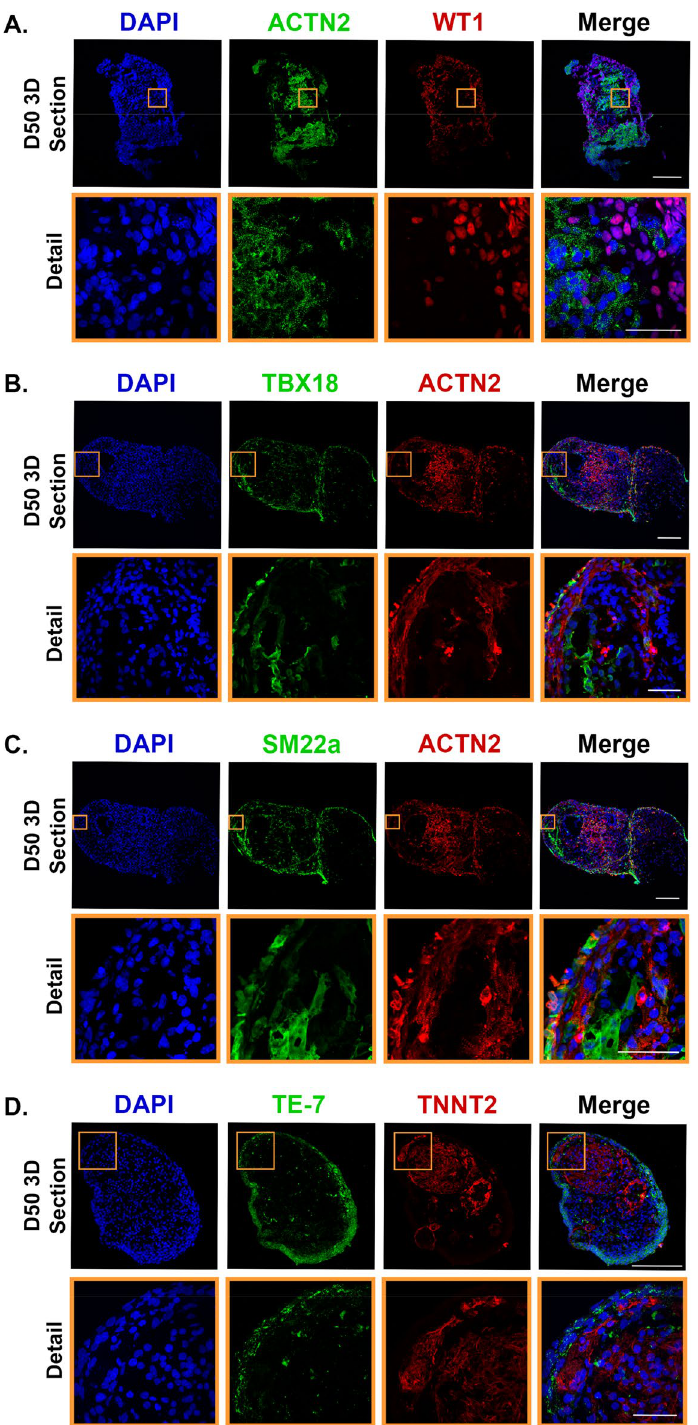
Figure 3. Long-term 3D culture of hOCMTs recapitulates advanced cardiac morphology and cellular heterogeneity in vitro showing markers for cardiomyocyte, epicardial and fibroblast cell types. Immunofluorescence analysis showing the representative co-specification of multiple cell type markers in 3D long-term cultured hOCMT sections on day 50 including cardiomyocytes ([ A – D ] ACTN2 in green or red, TNNT2 in red), epicardial cells ([ A ] WT1 in red, [ B ] TBX18 in green, [ C ] SM22a in green), epicardial/ fibroblastic and smooth muscle cells ([ C ] SM22a in green), “fibroblasts” ([ D ] TE-7 in green). Nuclei were counterstained with DAPI (blue). Full 3D hOCMTs scale bar = 200 µm, Detail scale bar = 50